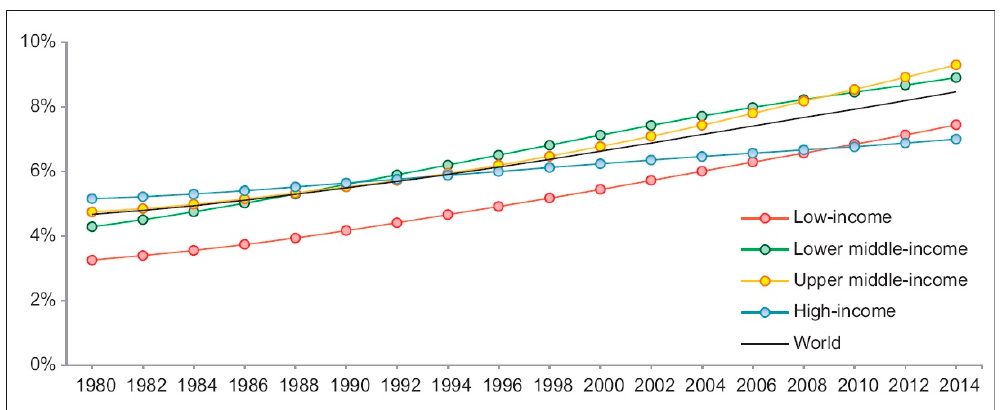
Figure 1. Trends in prevalence of DM from 1980 to 2014 by country income group. DM, diabetes mellitus [2] (permission number 391487).